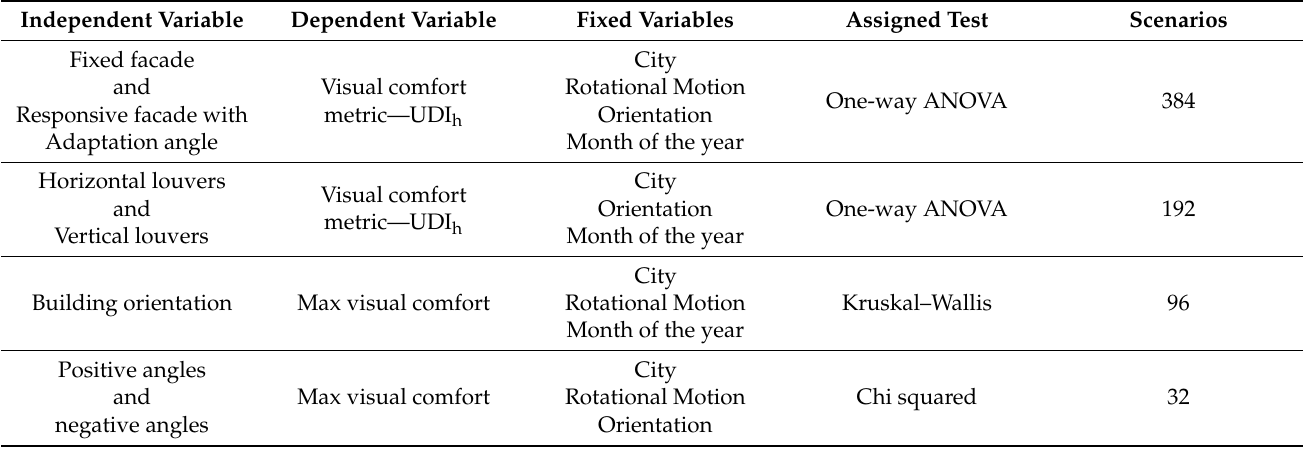
Table 1. Experimental settings for scenario